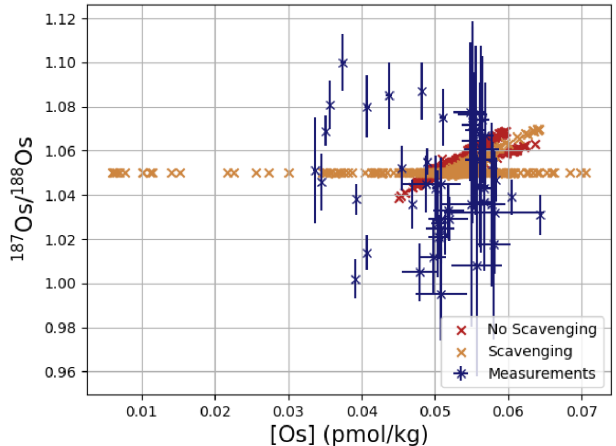
Figure A3. Cross plot of measured and simulated Os concentra- tions and isotopic compositions in seawater with and without Os scavenging under sub-oxic